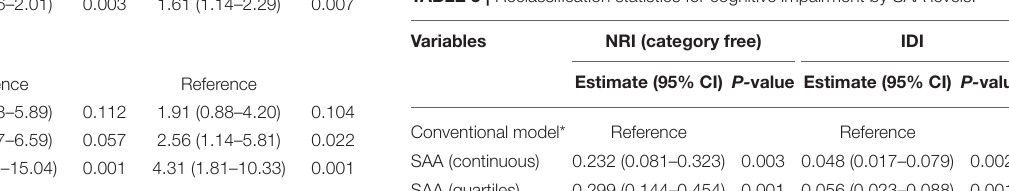
TABLE 3 | Reclassification statistics for cognitive impairment by SAA levels.